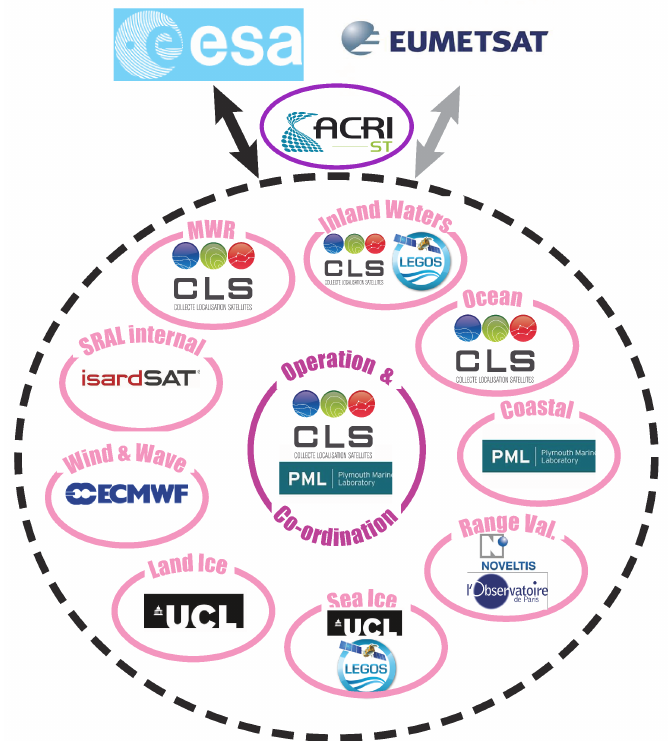
Figure 3. Organigram showing the areas of expertise of the various Expert Support Laboratories within the STM component of the S3MPC, and their interaction with ESA and EUMETSAT. Overall management of the S3MPC contract is provided by